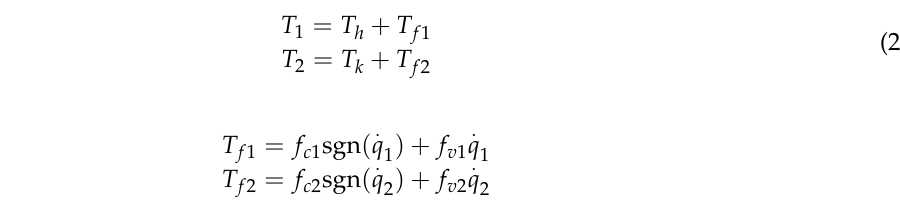
represent the friction